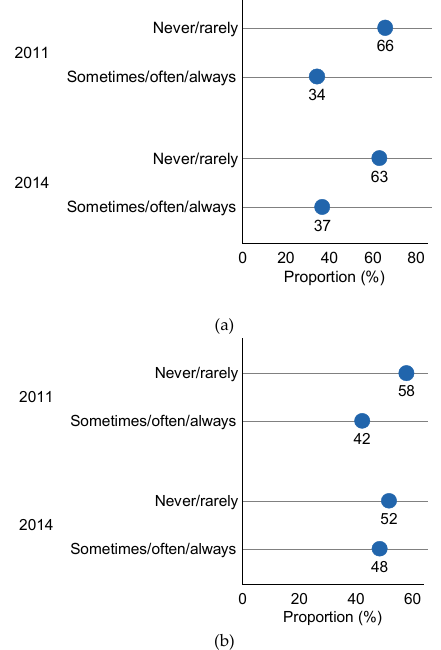
Figure 1. Frequency of salt use at the table and in cooking in 2011 and 2014. ( a ) Reported use of table salt in 2011 ( n = 598) and 2014 ( n = 442); ( b ) Reported use of cooking salt in 2011 ( n = 580 a ) and 2014 ( n = 438 b ); a Excludes 2 females and 16 males who reported not cooking; b Excludes 4 males who reported not cooking.